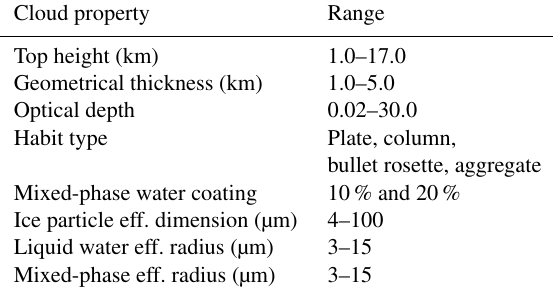
Table 1. Range of variability of the main cloud properties used in the simulations. The habit type indicates the assumed pristine shapes of the ice crystals. The mixed-phase water coating indicates the percentage of liquid water coating with respect to the dimen- sions of the assumed spherical